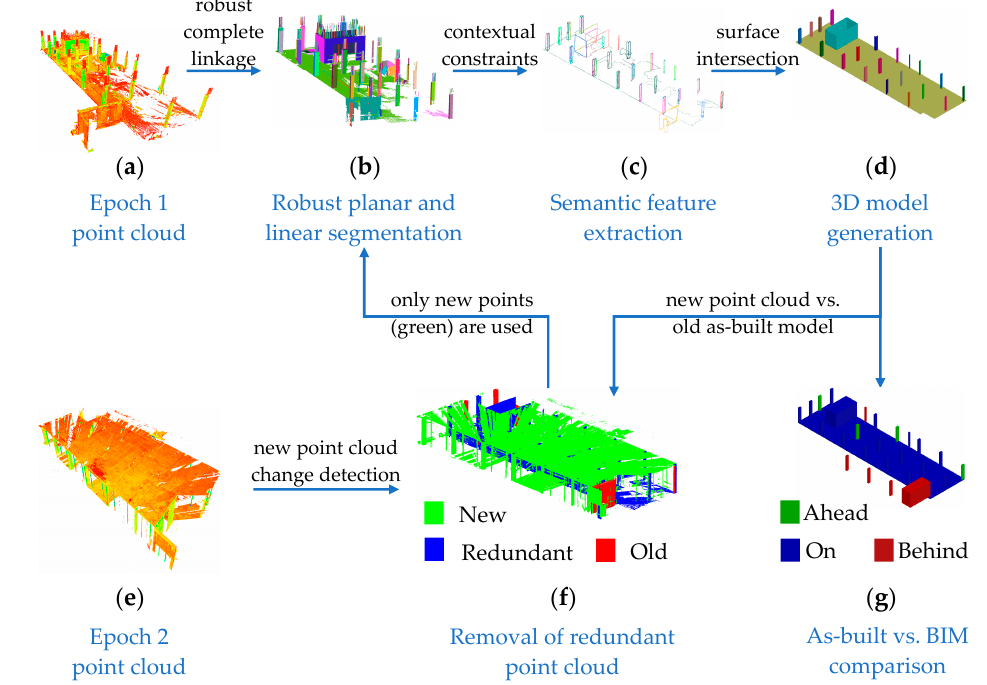
Figure 1. Step-by-step process for semantic extraction of regular rectangular reinforced concrete components: ( a ) point cloud of first epoch; ( b ) robust planar and linear segmentation using the method described in [22]; ( c ) extraction of semantic features, here concrete columns, using contextual constraints; ( d ) 3D model generation through surface intersection; ( e ) point cloud of the second (to last) epoch; and ( f ) removal of redundant points that had been modeled in the previous epoch.